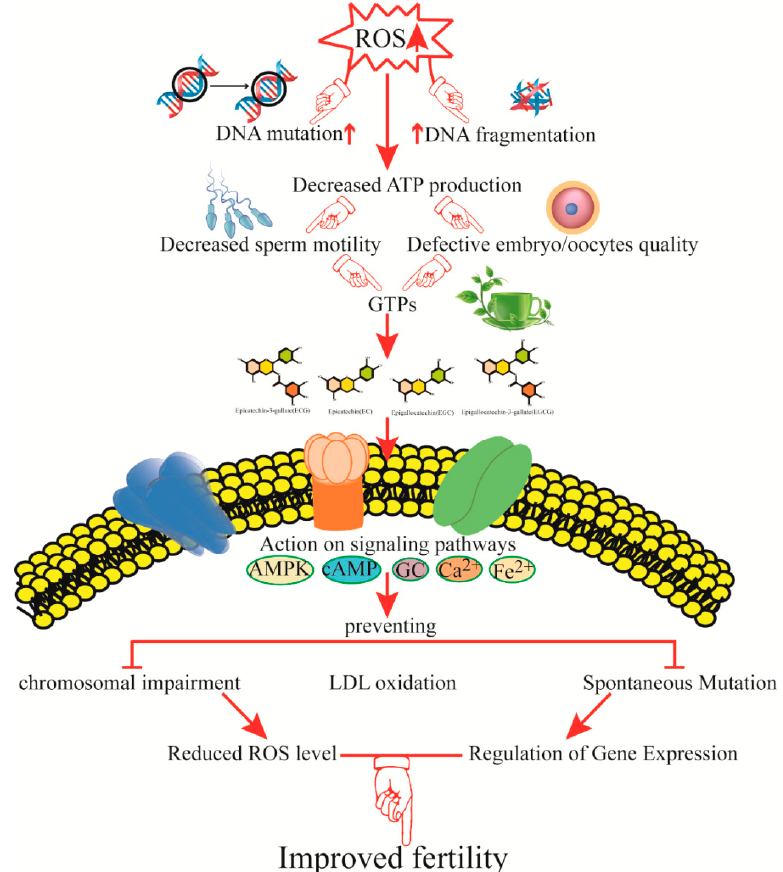
Figure 3. Mechanisms by which green tea catechins improve fertility and reproductive function. The figure shows potential mechanisms of action of green tea catechins in different pathways and proposes that green tea polyphenols (GrTPs) are capable of improving fertility by improving sperm and embryo quality. ROS, reactive oxygen species; ATP, adenosine triphosphate; AMPK, adenosine monophosphate-activated protein kinase; cAMP, cyclic adenosine monophosphate; Ca 2+ , calcium ion; Fe 2+ , ferric iron; LDL, low-density lipoprotein.